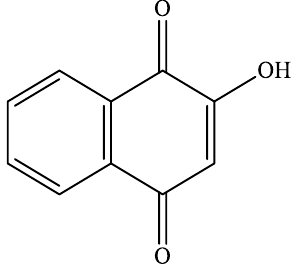
Figure 2. Structure of the Lawsone molecule.